Question: How would you classify this visualization?
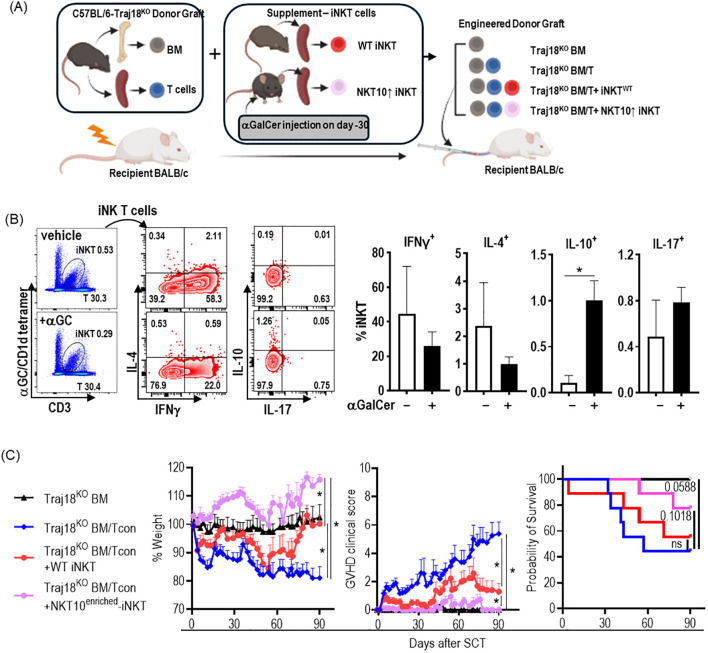
Answer: bar